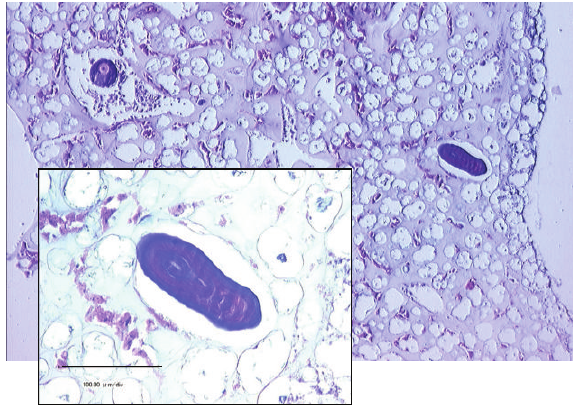
Figure 29: A commensal animal burrowed into the coenenchyme of Corallium konojoi ; OCA-Cn20090505-041. Scale bar is 0.1 mm.